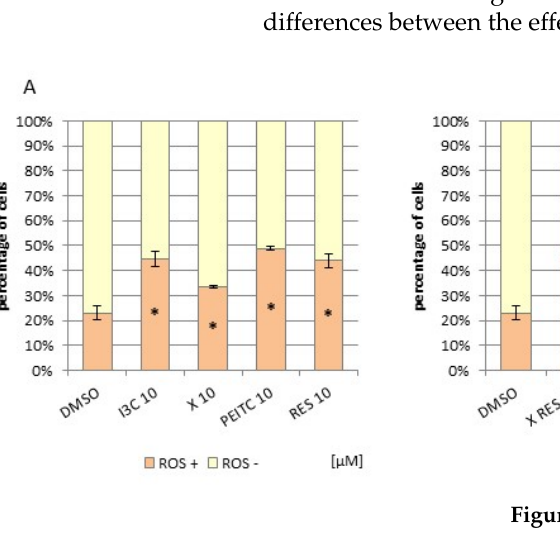
Figure 12. The impact of X, PEITC, RES, I3C, and their mixtures on the ROS production and on cell proliferation in HepG2 cells. Panel ( A ) The percentage of reactive oxygen species negative (ROS ( − ); M1) and positive (ROS (+); M2) cells based on dihydroethidium reaction with superoxide. The fluorescent signal was analyzed by flow cytometry. Exemplary plots are presented on the right side. Panel ( B ) The percentage of proliferating (Ki67 (+)) and non-proliferating (Ki67 ( − )) cells were analyzed by flow cytometry. Starved cells (cultured without FBS) were acted as a reference to antiproliferative con- ditions. Exemplary plots are presented. Results were calculated from three separate experiments (mean ± SEM). (*) above the bar indicates statistically significant differences from the control group, p < 0.05.